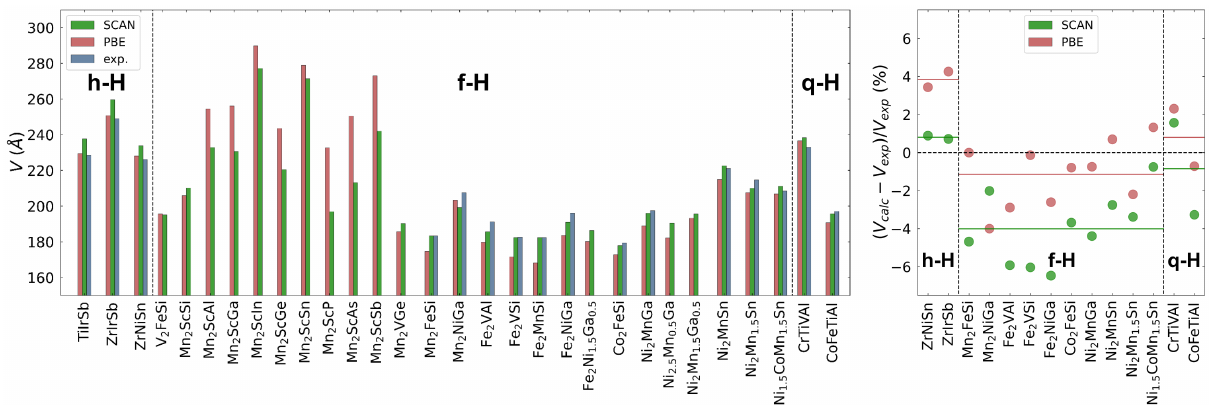
Figure 12. ( Left panel ) Optimized volume cell for half-, full-, and quaternary Heusler alloys denoted as h-H, f-H, and q-H, correspondingly, calculated by SCAN and PBE. ( Right panel ) The deviation of the calculated cell volume from the experimental one. The theoretical and experimental values of V were collected from Refs.